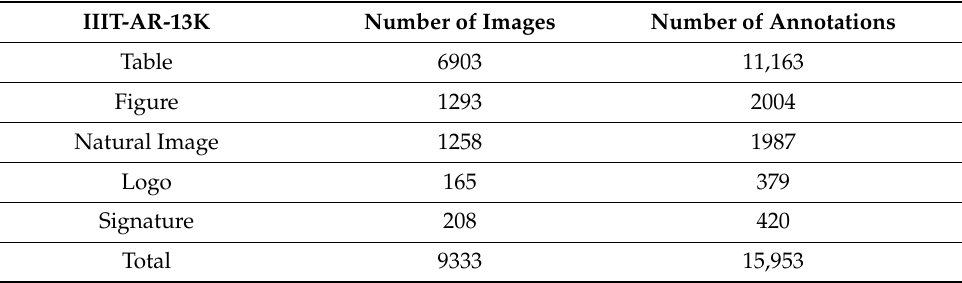
Table 2. Label-wise summary of IIIT-AR-13K training